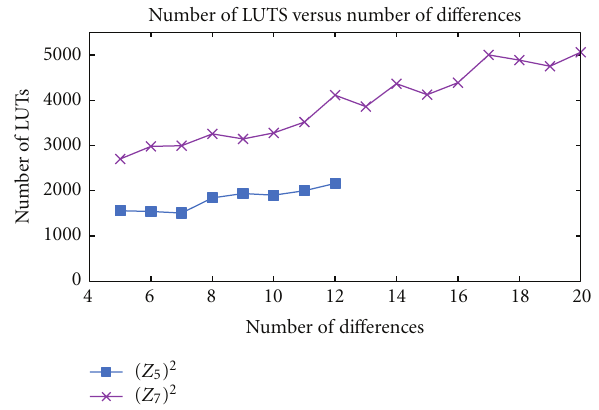
Figure 8: LUT utilization by the Costas enumeration module for various di ff erences in the evaluation block. The target device is a XC5VLX330-2, which contains 207360 LUTs.